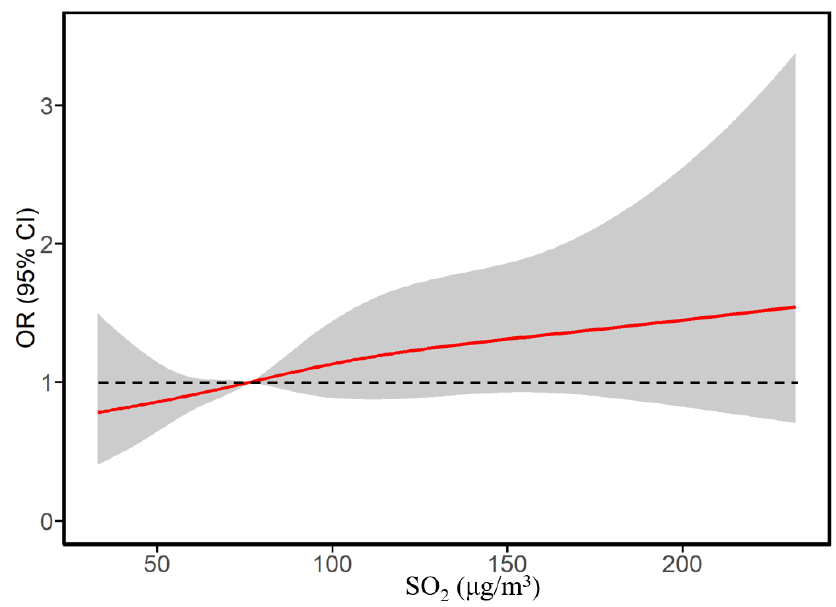
Figure 1. Concentration–response curves between exposure to SO 2 in the 1st trimester and risks of childhood annual SAR to pollen. OR (95% CI) was adjusted for all the covariates in Table 1.